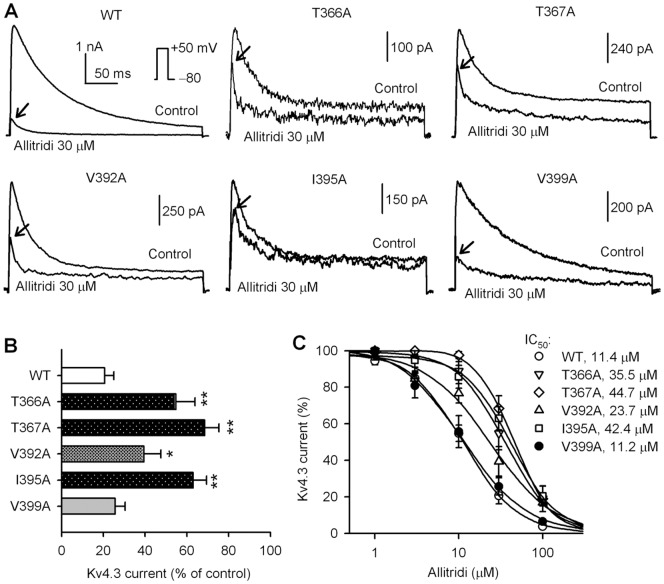
Molecular determinants of hKv4.3 channel block by allitridi.
A. Current traces recorded in HEK 293 cells expressing WT, T366A, T367A, V392A, I395A, and V399A hKv4.3 channels, respectively, with a 300-ms voltage step to +50 mV from a holding potential of −80 mV before (control) and after 30 µM allitridi treatment for 5 min. The arrows indicate the current inhibition levels. B. Mean percent inhibition of WT and mutant hKv4.3 currents by 30 µM allitridi (n = 18 for control, n = 7–9 for mutants; *P<0.05, **P<0.01 vs. WT). C. Concentration-response relationship curves were fitted to a Hill equation to obtain the IC50s of allitridi for inhibiting WT and mutant hKv4.3 channels as shown in the inset (n = 7–18 for each concentration).